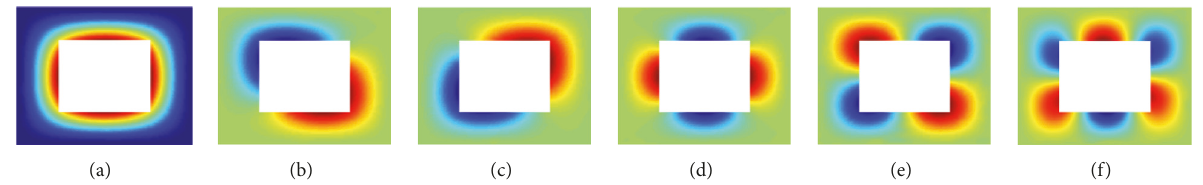
Figure 4: The first six mode shapes of the square plate with an inner cutout. (a) The first mode; (b) the second mode; (c) the third mode; (d) the fourth mode; (e) the fifth mode; (f) the sixth mode.